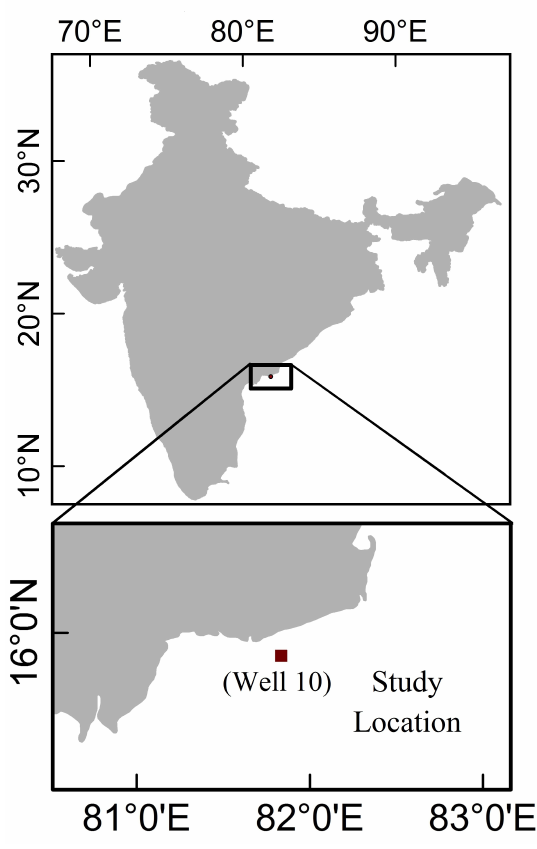
Figure 1. Location map of the study